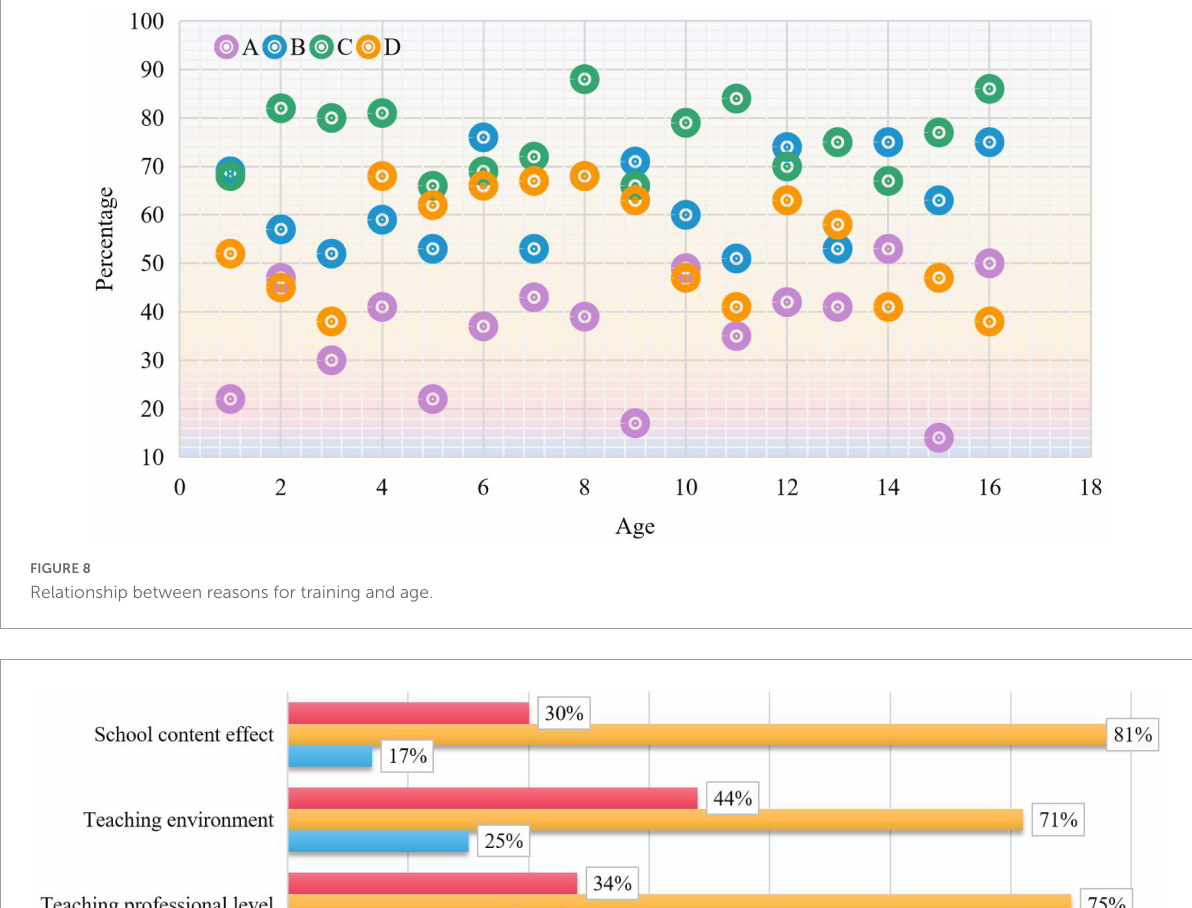
FIGURE9 Distribution of perceived quality